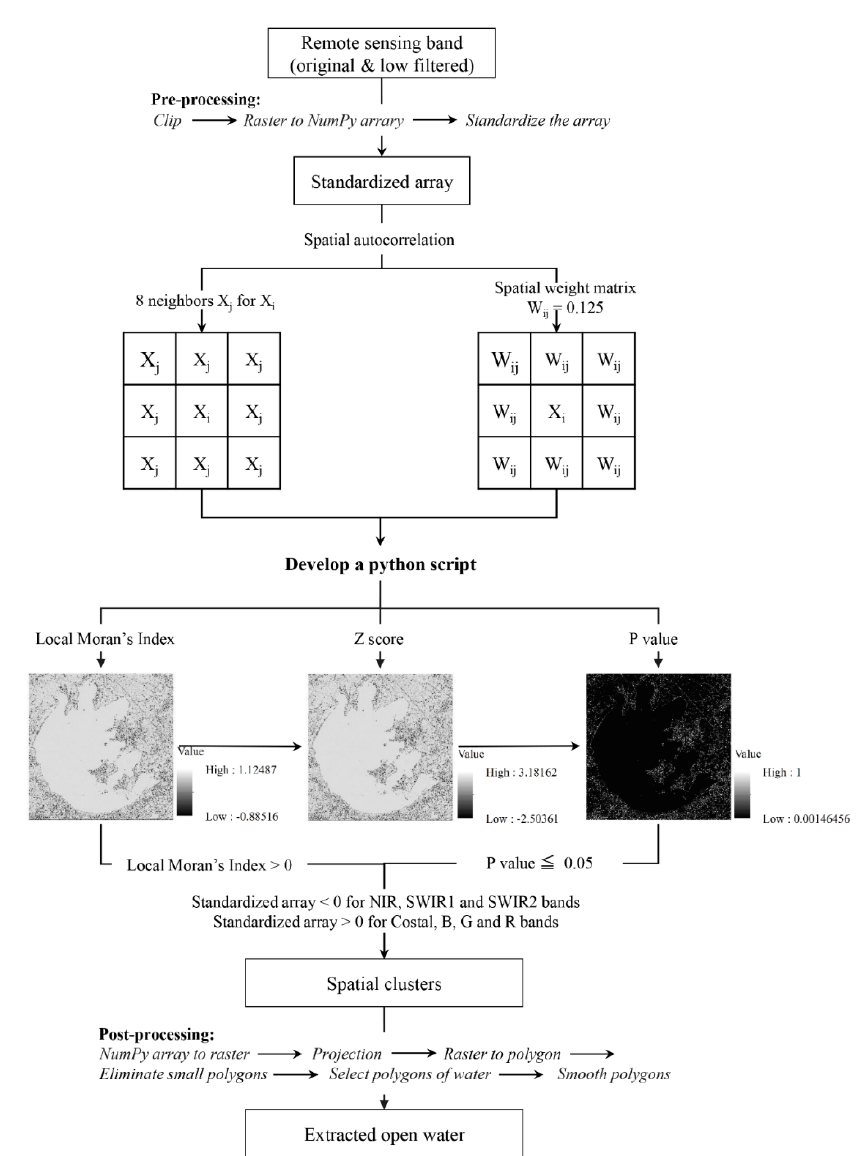
Figure 2. Methodology flowchart. B = blue band; G = Green band; R = Red band; NIR = Near-infrared band; SWIR1 = first shortwave infrared band; SWIR2 = second shortwave infrared band; Spatial clusters = low – low clusters (i.e., low value pixels significantly cluster together spatially) or high – high clusters (i.e., high value pixels significantly cluster together spatially).